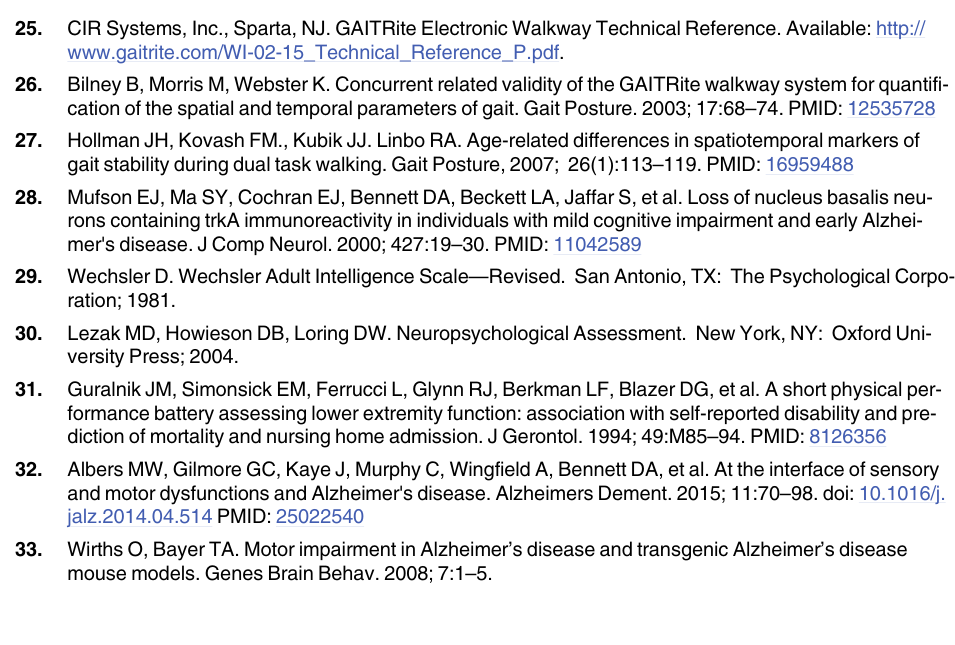
PLOS ONE | DOI:10.1371/journal.pone.0156732 August 3,